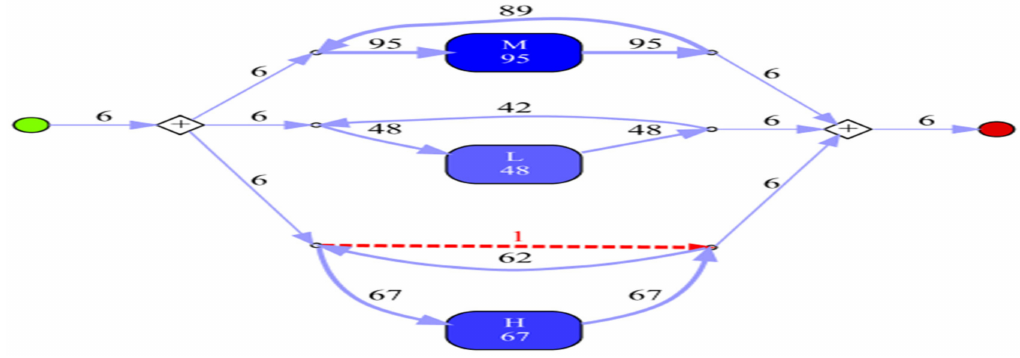
Figure 12. IvM process model with deviations or bottlenecks in Class H.